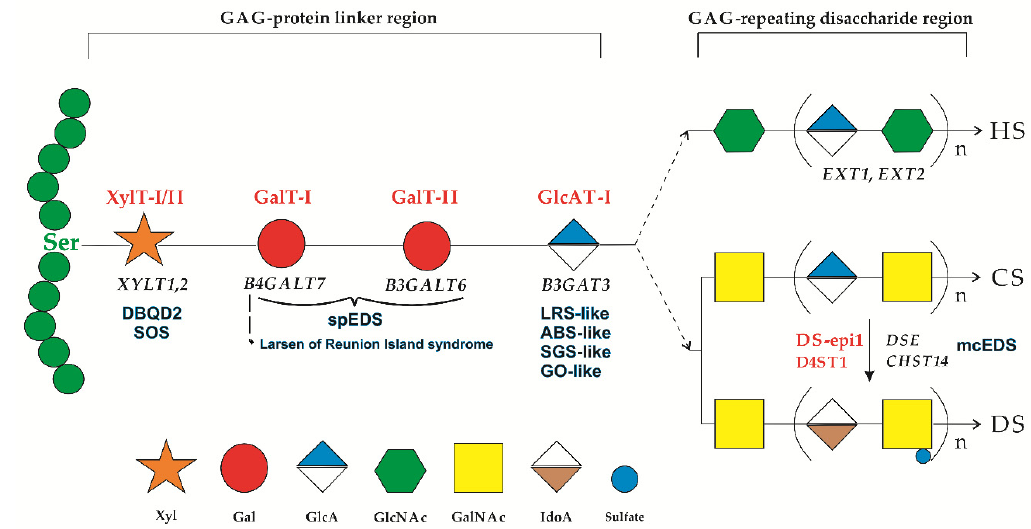
Figure 1. Biosynthetic assembly of the glycosaminoglycan (GAG) backbones of heparan sulfate (HS) and chondroitin sulfate (CS) / dermatan sulfate (DS) chains and related genetic disorders. Each enzyme (in red) and its coding gene (in black) are described near the sugar symbols. After the synthesis of specific core proteins, the synthesis of the GAG-protein linker region is initiated by XylT-I / II, which transfers [Xyl] to the specific Ser residue in the endoplasmic reticulum. The synthesis of the linker region is completed by the consecutive addition of two molecules of [Gal], added by GalT-I / II, followed by the transfer of [GlcA] catalyzed by GlcAT-I in the Golgi. The addition of a [GalNAc] to the linker region commits the growing GAG chain to CS / DS. CS synthesis proceeds with the alternating addition of [GlcA] and [GalNAc] and can be further modified by sulfotransferases. A DS chain is generated after the formation of the chondroitin backbone, when [GlcA] is converted into [IdoA] by DS-epi1, resulting in the formation of the dermatan backbone, where [GalNAc] is sulfated by D4ST1. Alternatively, the addition of the [GlcNAc] to the linker region induces HS biosynthesis. The polymerization of the HS chain is catalyzed by enzymes encoded by the EXT1 and EXT2 genes. Abbreviations : Ser, Serine; HS, heparin sulfate; CS, chondroitin sulfate; DS, dermatan sulfate; XylT-I / II, xylosyltransferases I / II; GalT-I, galactosyltrasferase I; Galt-II, galactosyltrasferase II; GlcAT-I, glucuronasyltransferase I; DE-epi1; dermatan sulfate epimerases; D4ST1; dermatan 4- o -sulfotransferase 1; Xyl, xylose;